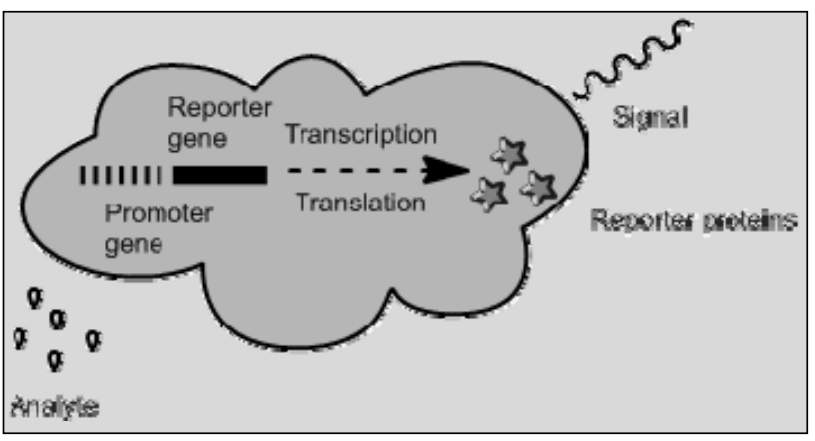
Figure 6. Mechanism of bioreporters (adapted from